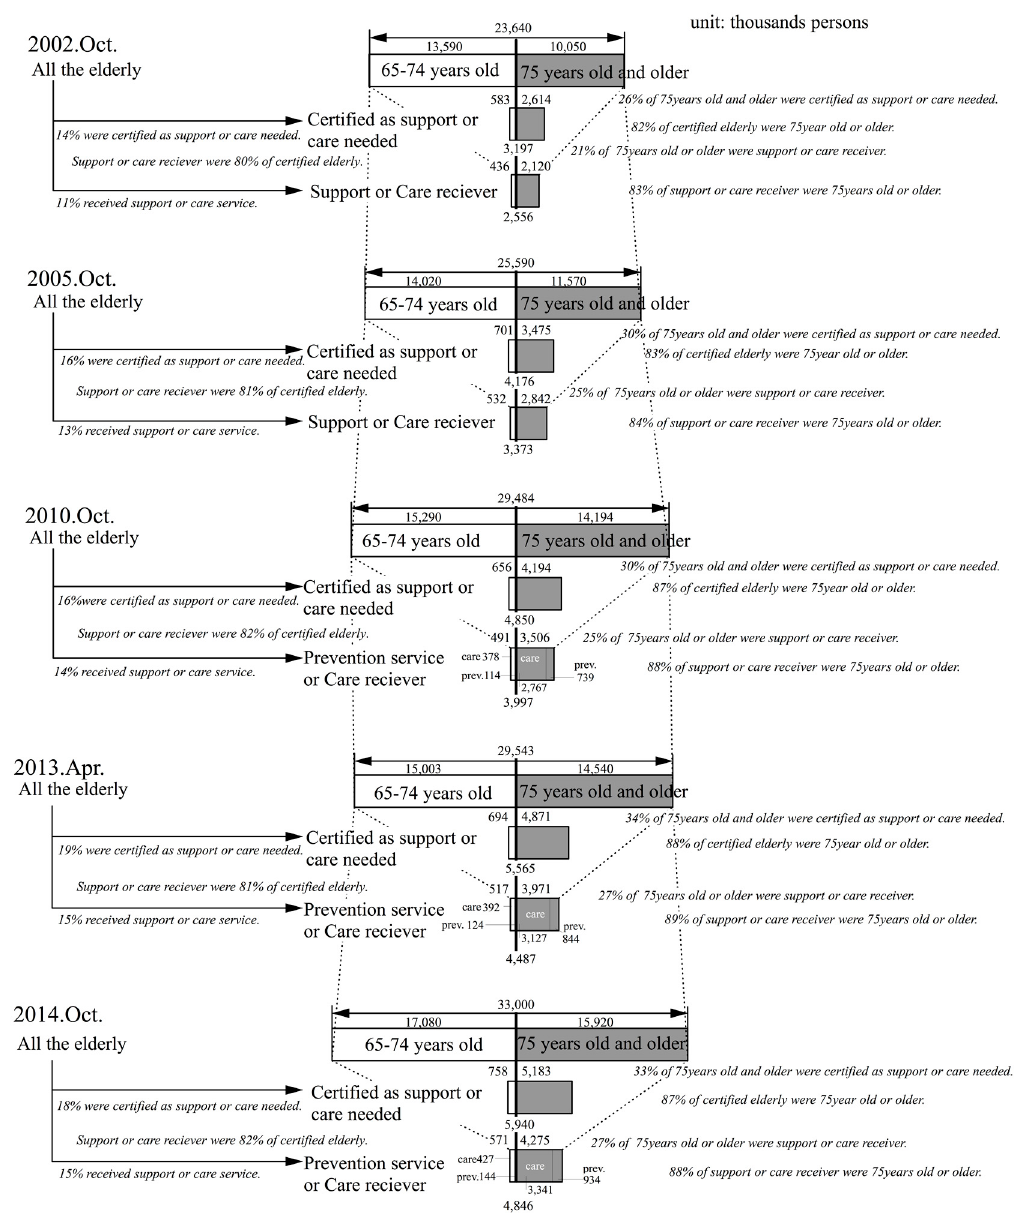
Figure 2. Total number of elderly, certified, and receiver of care services in nationwide Japan (2002, 2005, 2010, 2013, and 2014 in chronological order).